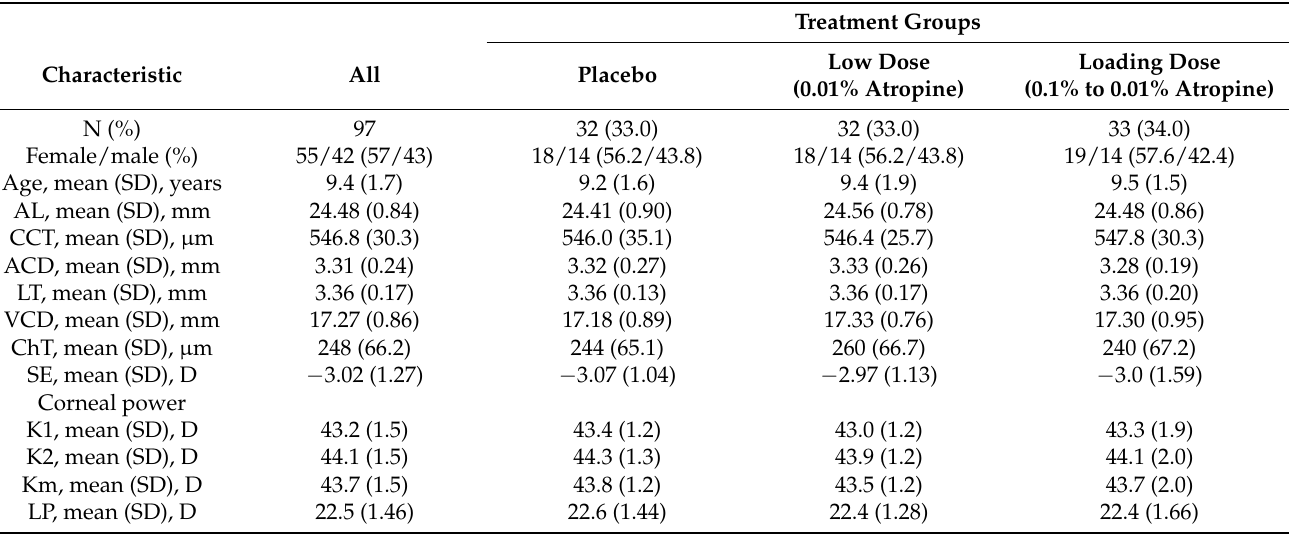
Table 1. Baseline demographics and ocular parameters of randomized